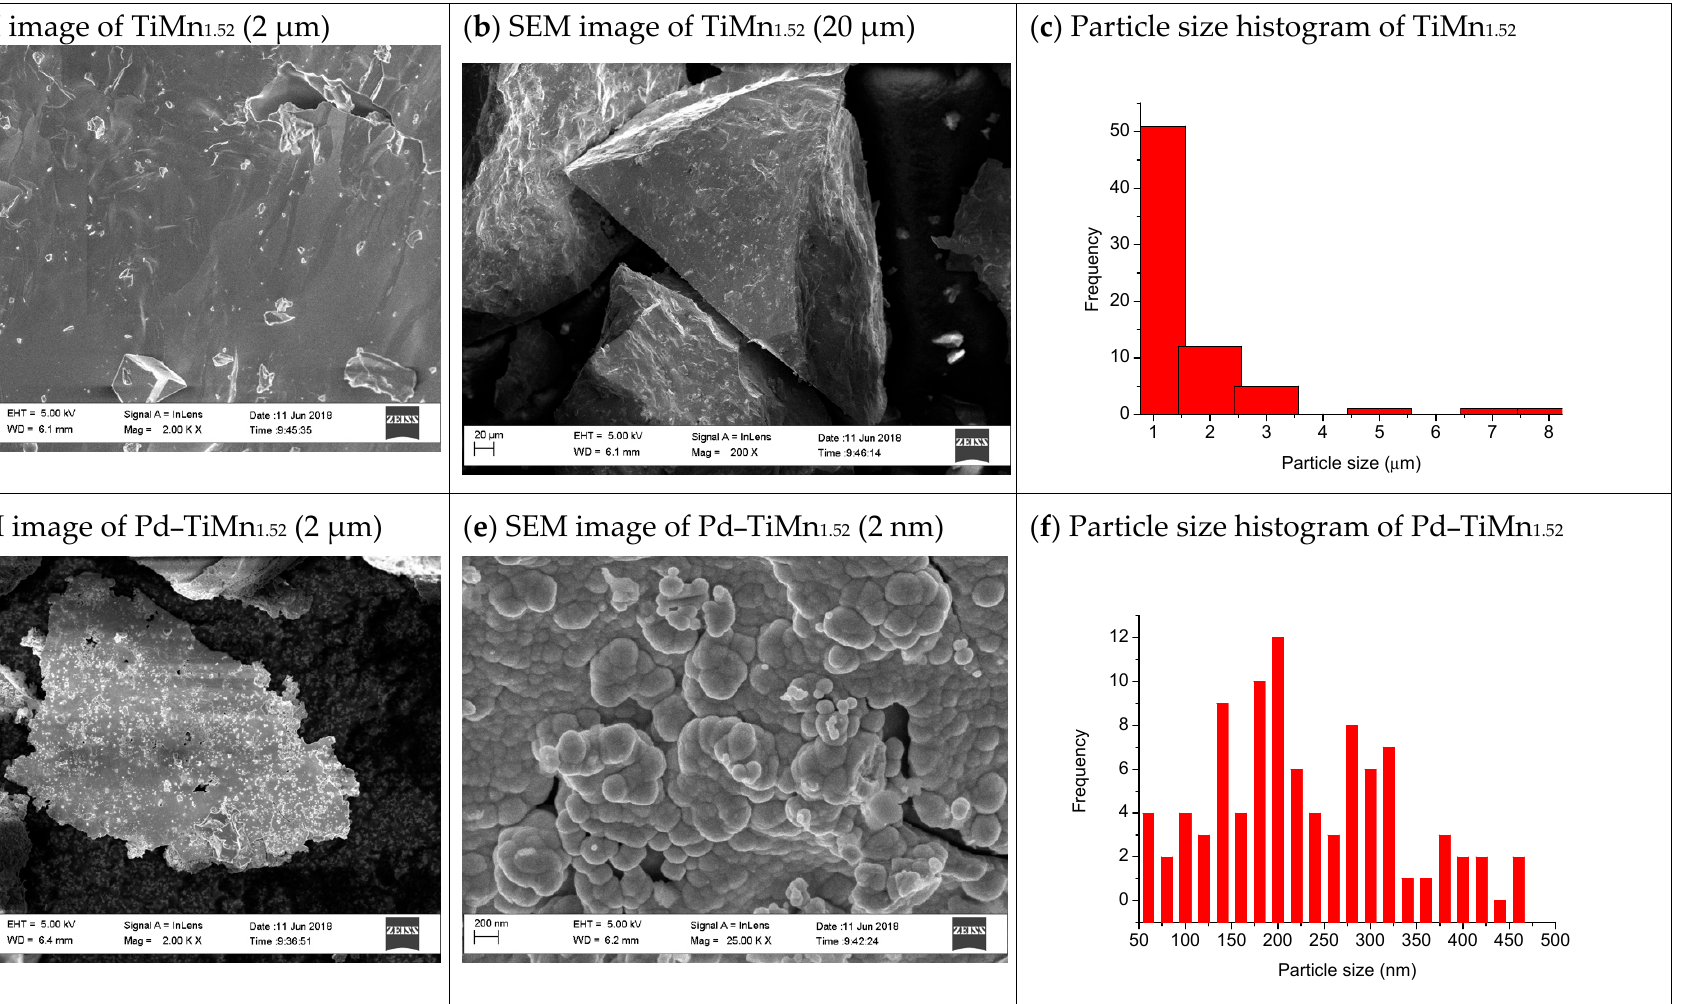
Figure 2. Scanning electron microscope (SEM) micrographs of ( a , b ) TiMn 1.52 and ( d , e ) Pd–TiMn 1.52 and their particle size distribution histograms (( c ) TiMn 1.52 and ( f ) Pd–TiMn 1.52 ).